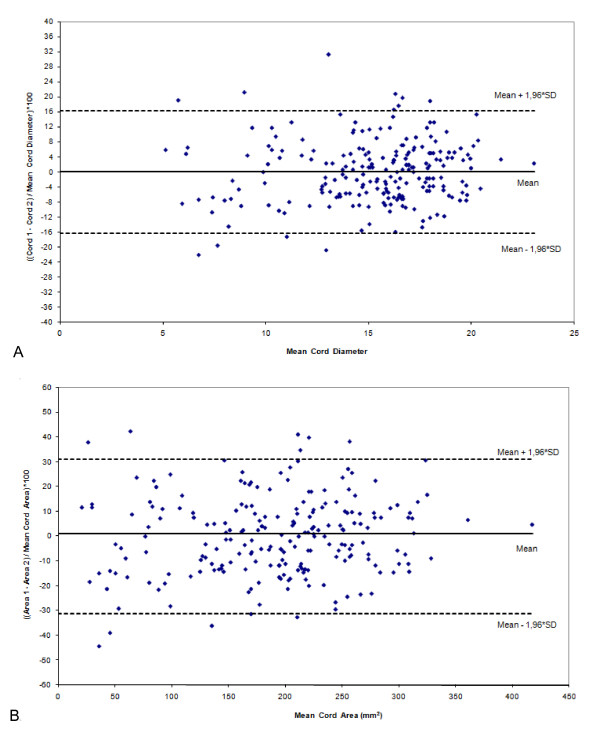
Inter-observer agreement by plotting the mean differences against the mean values (method of Bland & Altman) for the following measurements: A. Diameter of the umbilical cord (cord1 and cord2 are respectively the measurements of observer 1 and 2); and B. diameter of the area of the umbilical cord (area1 and area2 are respectively the measurements of observer 1 and 2).